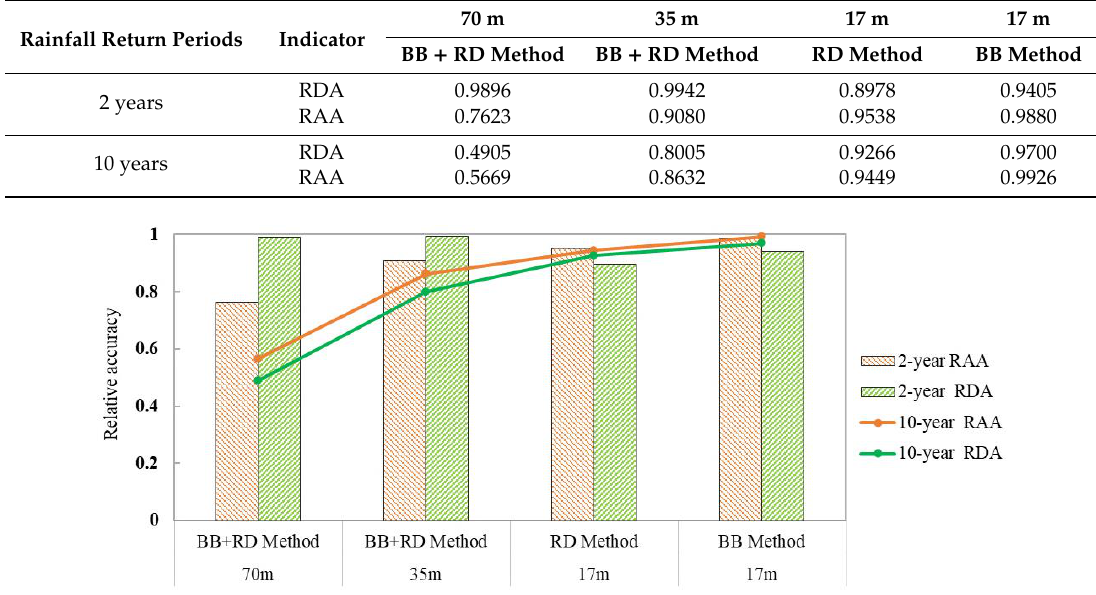
Table 4. The indicators for all simulated events for different contrast cases. RDA, relative depth accuracy; RAA, relative area accuracy.